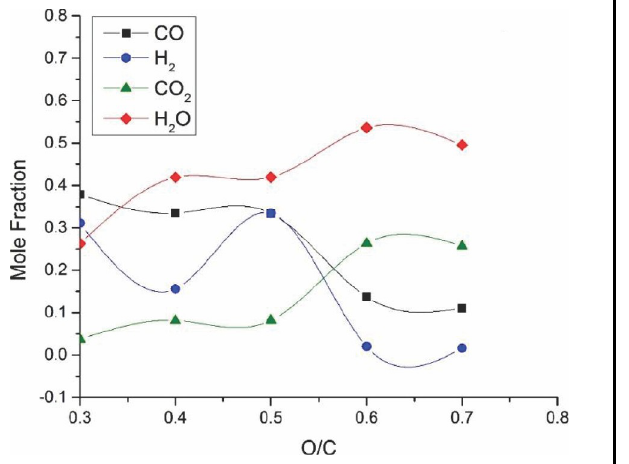
FIG. 3. LAKHRA COAL SYNGAS MOLAR COMPOSITION AT VARYING O/C RATIOS